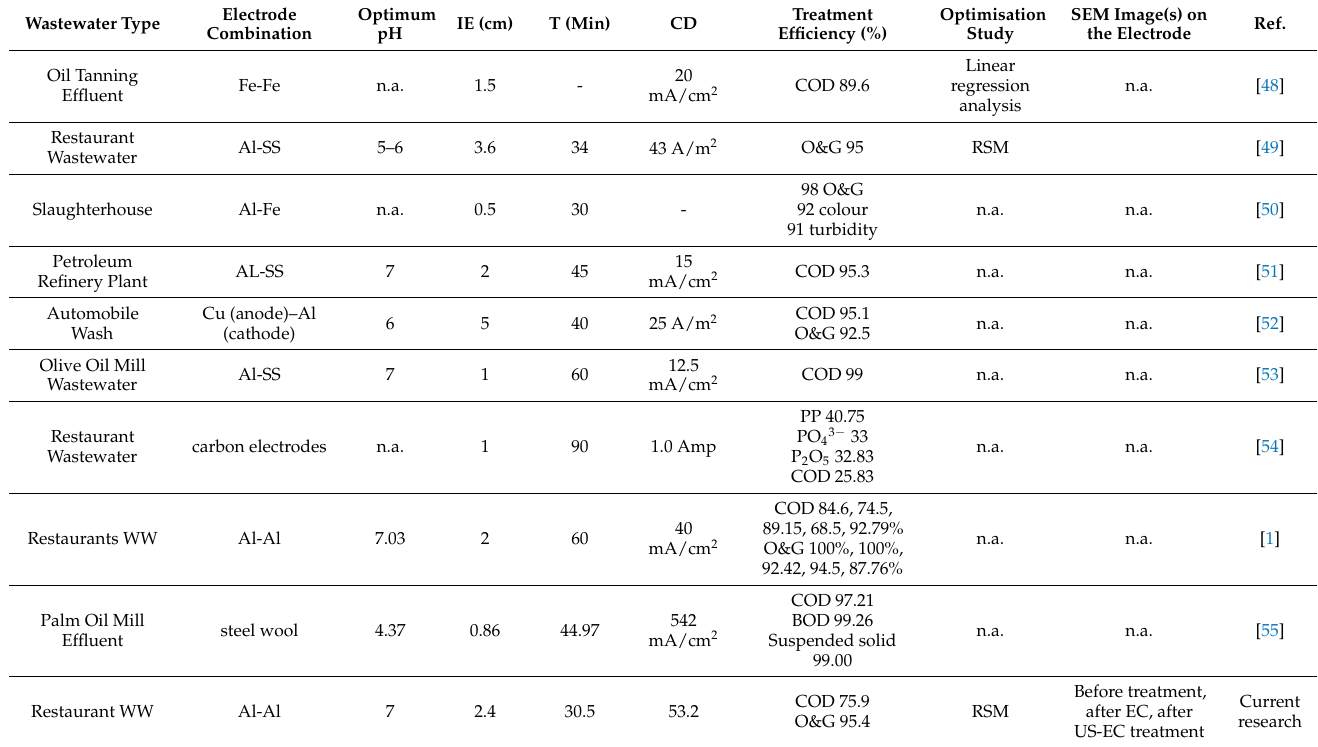
Table 1. The application of EC process for oily wastewater